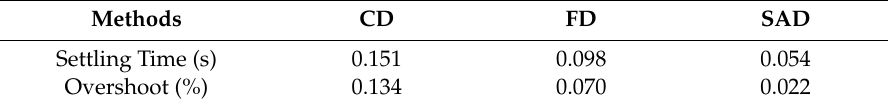
Table 3. Comparison of di ff erent control strategies when J is based on frequency change rate. Figure 11. Comparison of frequency under different damping control strategies when J is based on frequency change rate.